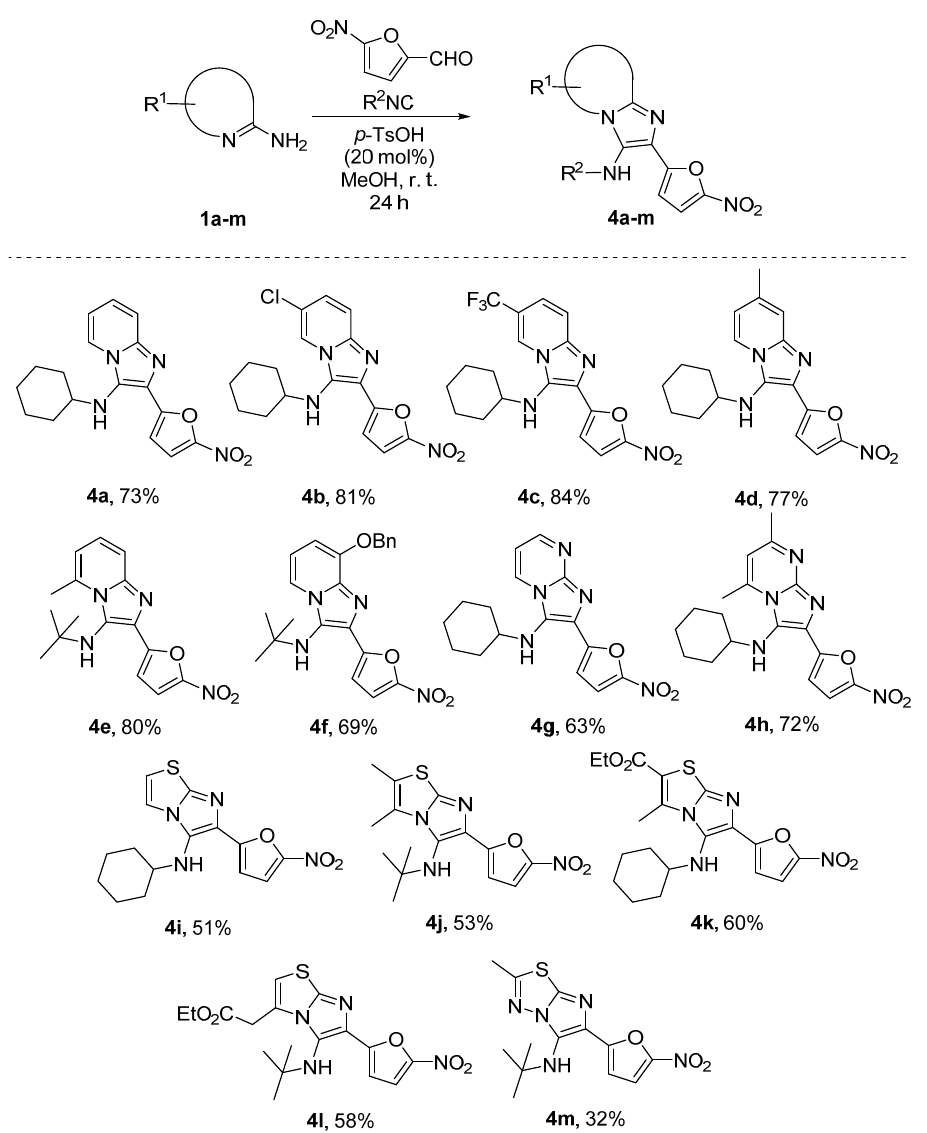
Scheme 1. Synthesis of imidazo-fused products of the GBB reaction with 1a–m showing the structure and percentage yield of each compound.